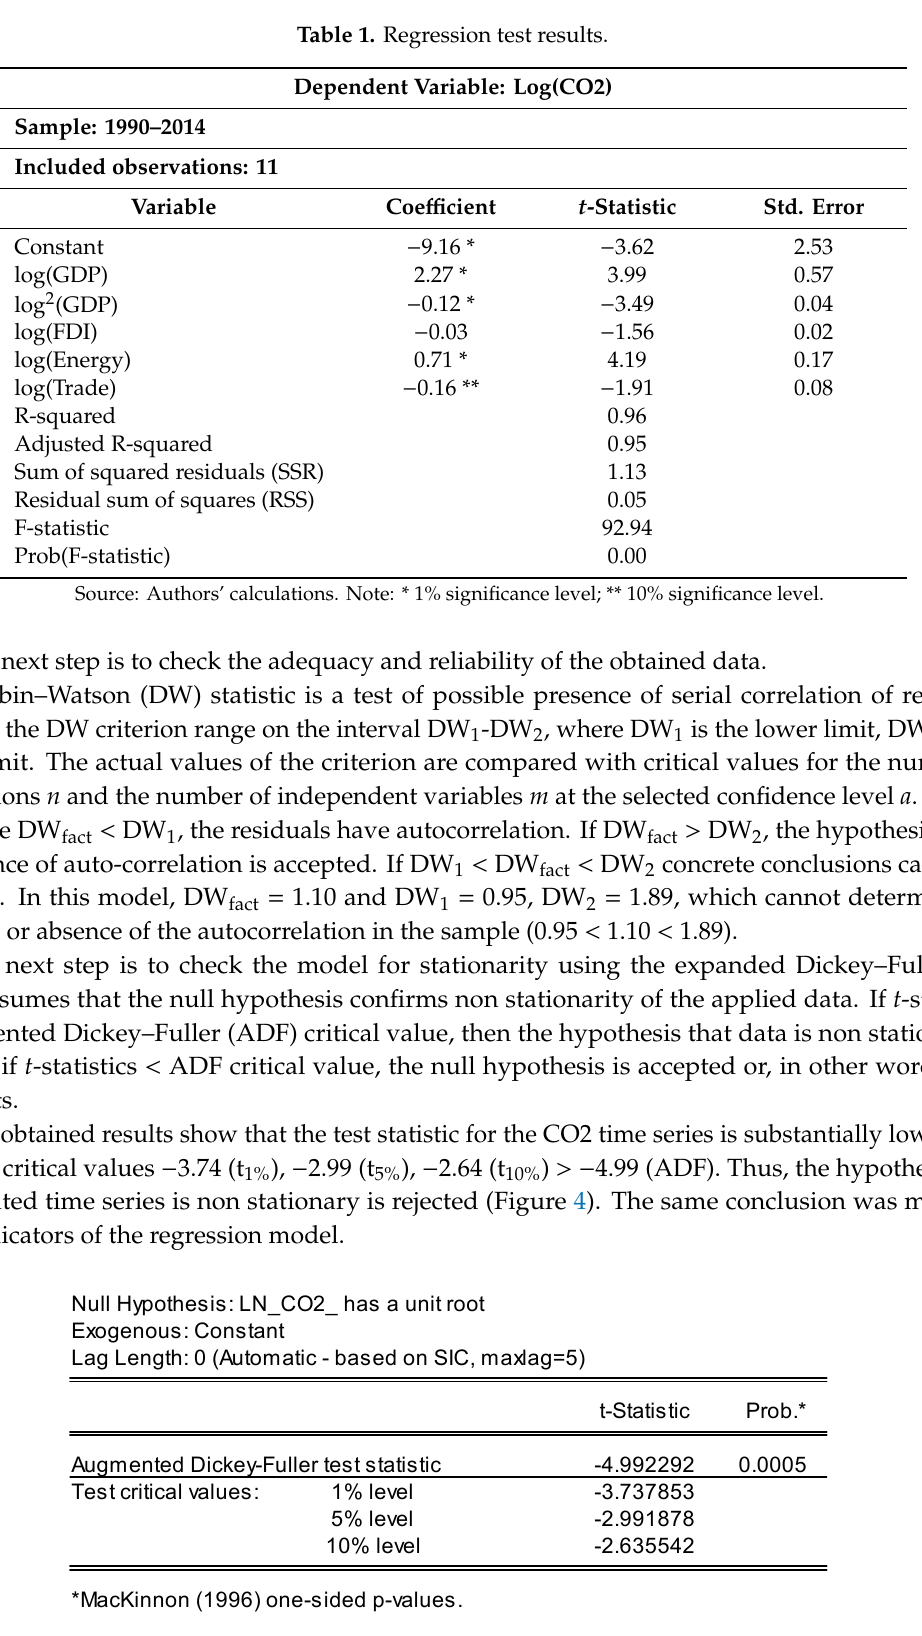
Figure 4. Results of the check on the stationary time series in the EViews program.